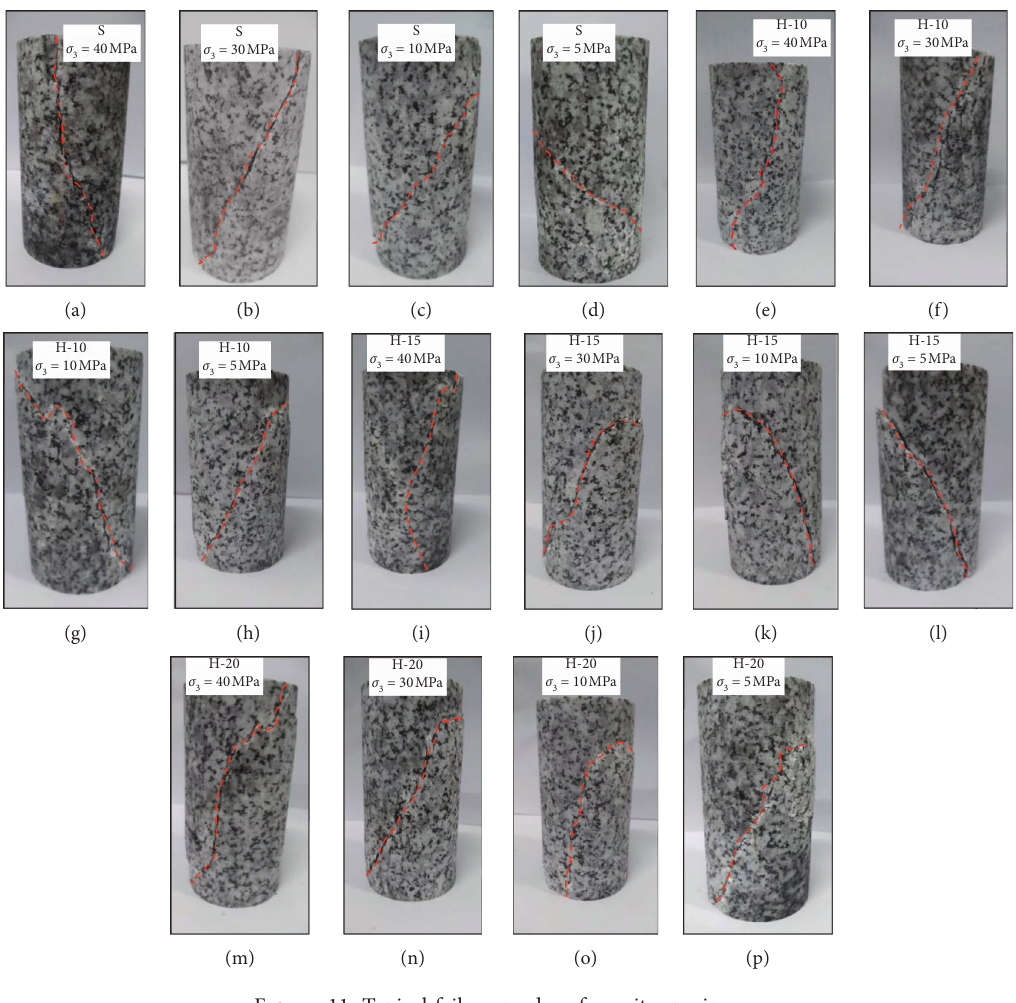
Figure 11: Typical failure modes of granite